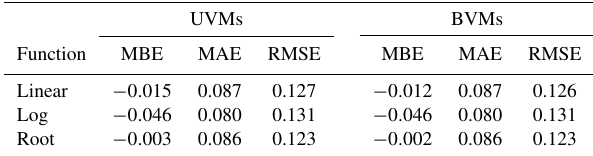
Table 4. Error metrics for the univariable and bivariable